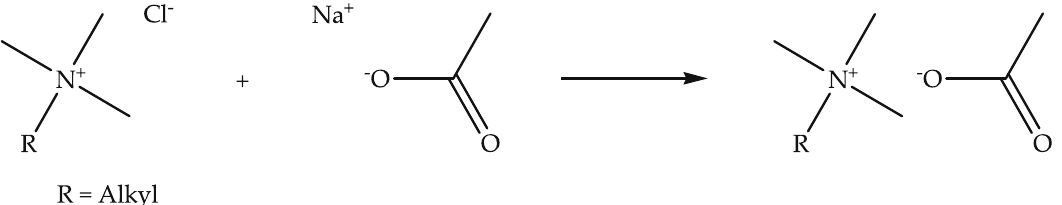
Figure 5: Schematic representation of the metathesis reaction of quaternary ammonium chloride with sodium acetate to synthesize the quaternary ammonium acetate ionic